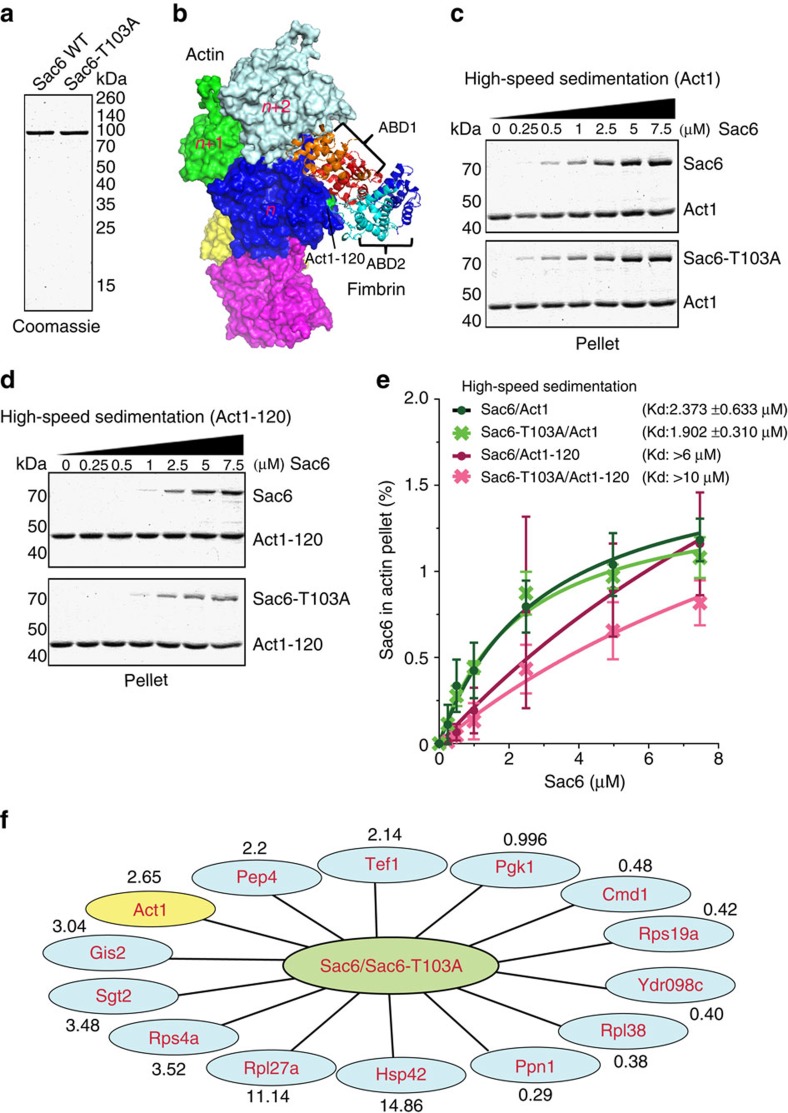
Phospho-mutation of Sac6 attenuates its yeast F-actin-binding capacity and other interaction partners.(a) Coomassie blue-stained gels of yeast-purified Sac6 WT and Sac6-T103A. (b) Structural model of actin filament (PDB ID: 3J8I)69 and fimbrin proteins (PDB ID: 1RT8)70 using PyMOL. Five actin monomers coloured white, green, blue, yellow and purple, respectively, are shown in the F-actin structure. Corresponding mutated residues for Act1-120 (E99A, E100A) are indicated in green on the actin monomer ‘n'. Four calponin homology (CH) domains, CH1–CH4, in fimbrin's actin crosslinking core ABD1 and ABD2 are shown in red, orange, cyan and blue, respectively. (c,d) Coomassie blue-stained gels of actin filament pellets after a range of Sac6 and Sac6-T103A concentrations were added. F-actin was assembled from 1.25 μM Mg-ATP-yeast actin, incubated with Sac6 or Sac6-T103A, and spun at 100,000g for 20 min. Molecular weight is indicated on the left. (e) Plot of the amount of (•) Sac6 WT and (X) Sac6-T103A pelleted with Act1 (green) and Act1-120 (magenta), respectively, over a range of fimbrin concentrations. Curve fits revealed an equilibrium dissociation constant of Sac6 variants (•, green) 2.373±0.633 μM (s.e.) for Sac6/Act1 (n=3), (X, green) 1.902±0.310 μM (s.e.) for Sac6-T103A/Act1 (n=3), (•, magenta) >6 μM for Sac6/Act1-120 (n=4) and (X, green) >10 μM for Sac6-T103A/Act1-120 (n=4). (f) Interaction partners of Sac6 and Sac6-T103 were identified by SILAC coupled mass spectrometry and displayed using Cytoscape. The data were normalized to Sac6 protein. Differences in ratios measured for the binding partners of Sac6 and Sac6-T103A are indicated by numbers.